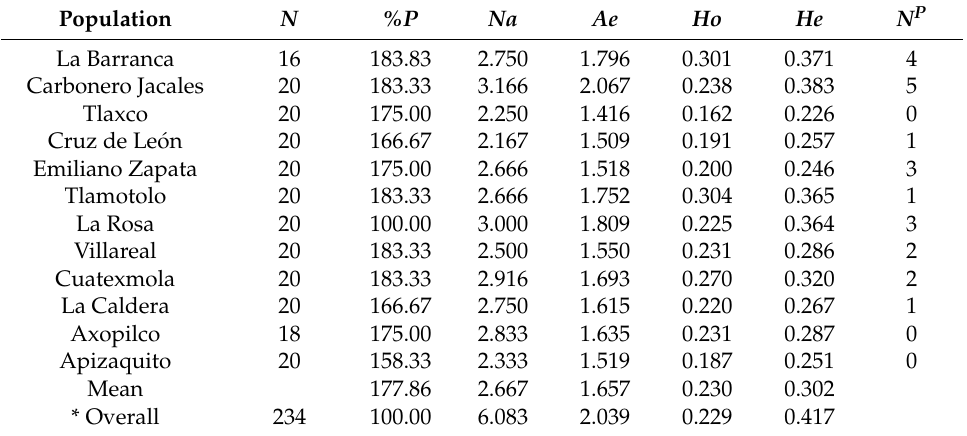
Table 4. Genetic diversity parameters in the 12 natural populations of Pseudotsuga menziesii (Mirb.) Franco, included in this